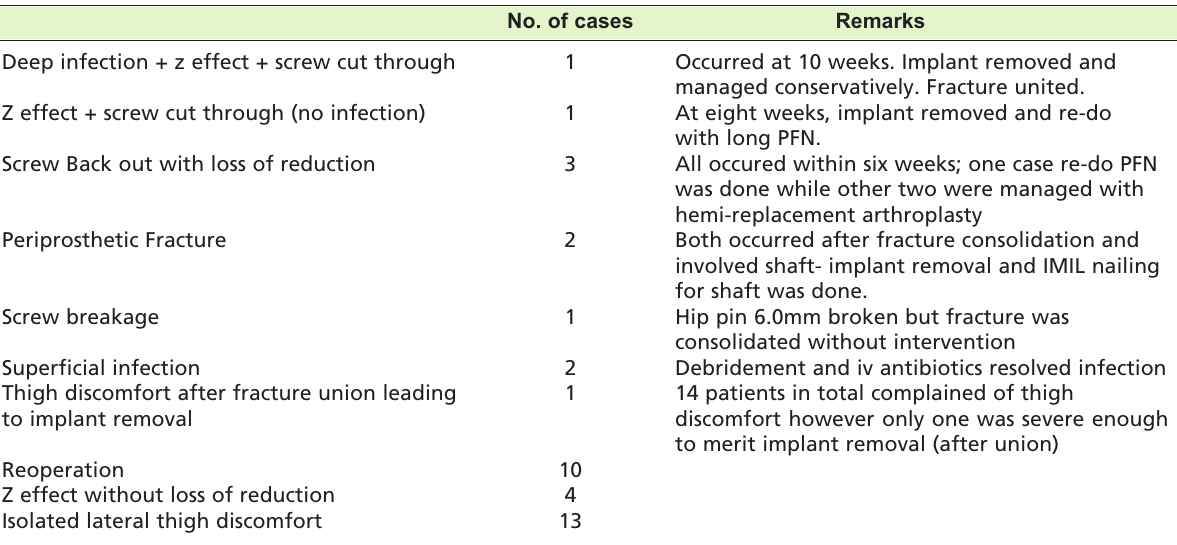
Complications Table V: